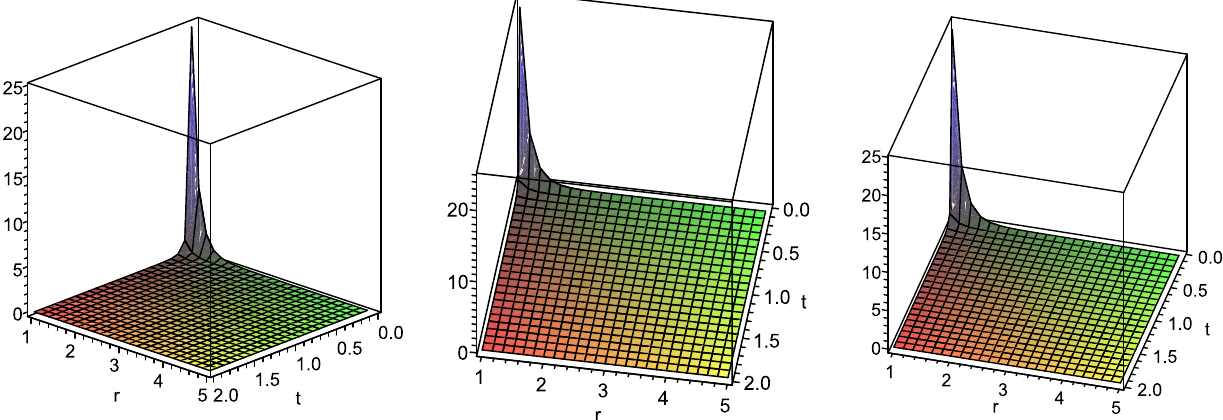
Fig. 5 The behavior of ρ , ρ + p r and ρ + p t versus r and t respectively from left to right, for w = − 1, r 0 = 1, R 3 = 1 and α = − 0 . 5 in 5-dimensions